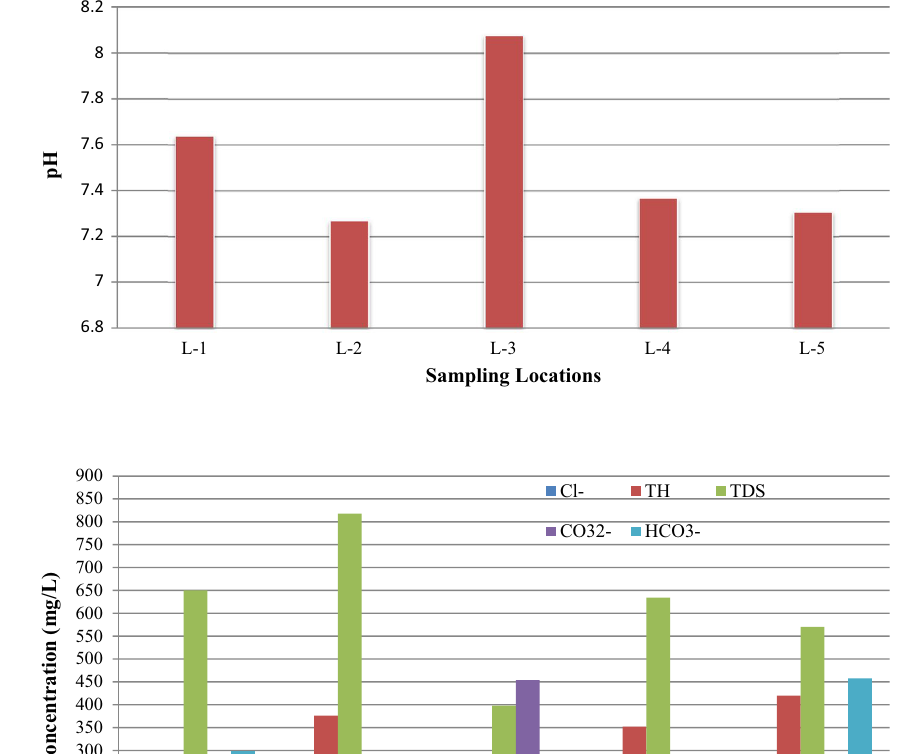
Fig. 4 Variation of SO 42− , NO 3− , Na + , Ca 2+ and Mg 2+ con- centrations at different